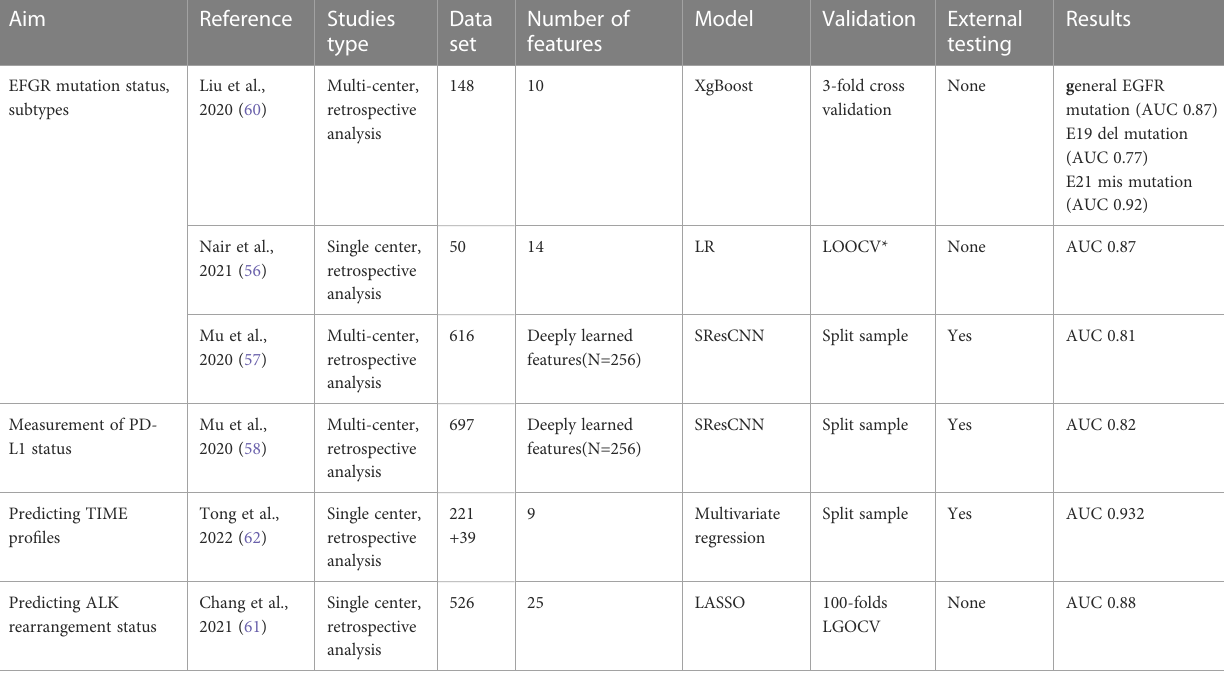
TABLE 3 Main fi ndings on